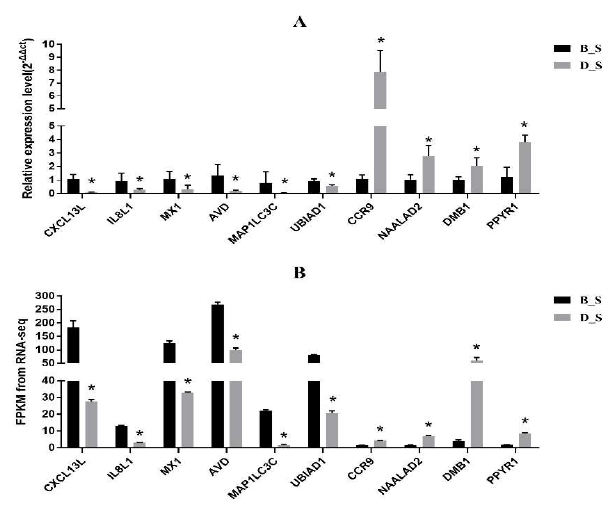
Figure 6. qRT-PCR corroboration of RNA-seq results. ( A ) The qRT-PCR result. ( B ) The RNA-seq result. The black column is the B_S group, and the gray column is the D_S group, * indicates significant difference ( p < 0.05).